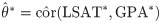
Comparison between the data re-sampling approaches and the vectorized multinomial sampling bootstrap, in a subset of the American law school data.Panel a compares the approach’s time expenditures. Panels b, c and d compare, respectively, the computation time ratio of the “for loop”, “R/bootstrap” and “R/boot” approaches against the vectorized bootstrap. The bottom panels present the θ^*=co^r(LSAT*,GPA*) distributions generated with B = 1,000,000.